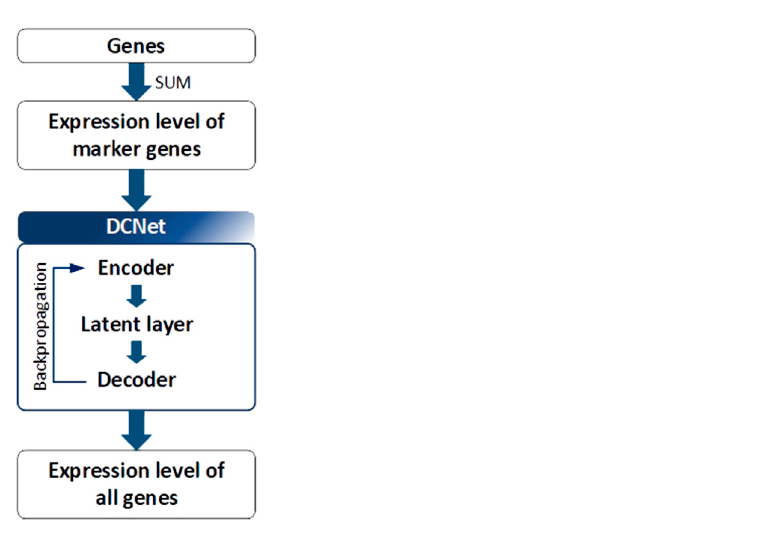
FIGURE 5 Architecture of DCNet. Geneexpression levels were considered to be input and output neurons in DCNet. The expression levels of marker genes and all genes are used as input and output neurons, respectively. Finally, the encoder layer and latent layer of the neural network are transferred, and the activation value of the latent layer indicates the abundance ratio of